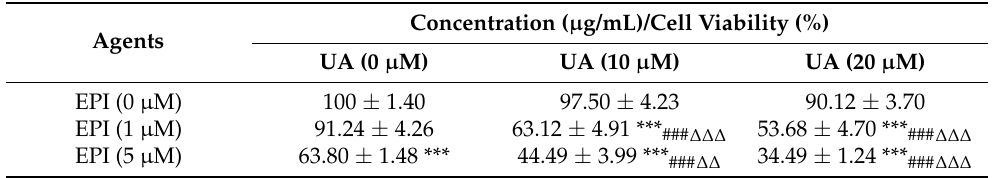
Table 2. The percentage of MDA-MB-231 viability was affected by ursolic acid, epirubicin, and ursolic acid combined with epirubicin 1 . Data represent means ± SEM ( n = 3).